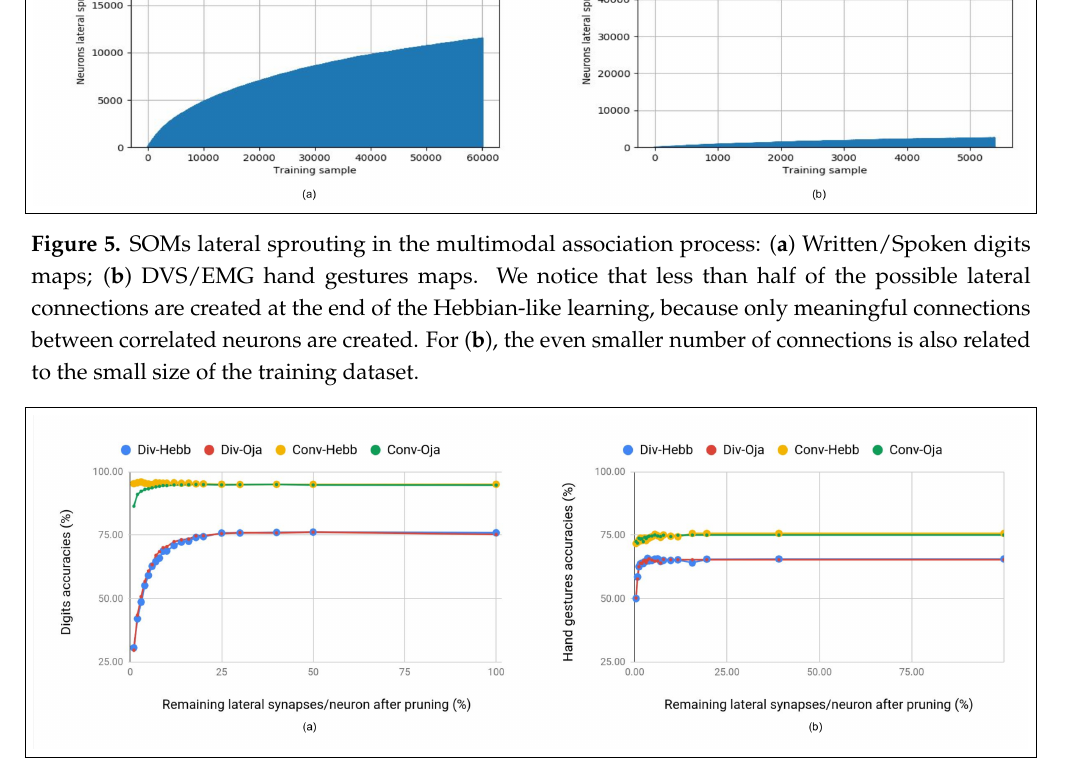
Figure 6. Divergence and convergence classification accuracies VS . the remaining percentage of lateral synapses after pruning: ( a ) Written/Spoken digits maps; ( b ) DVS/EMG hand gestures maps. We see that we need more connections per neuron for the divergence process, because the pruning is done